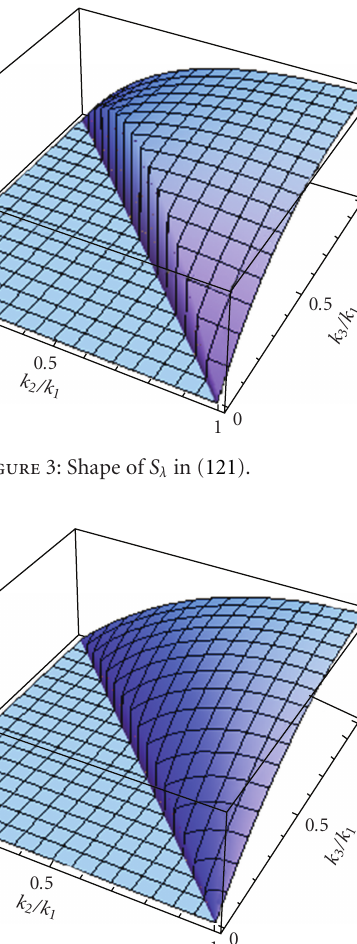
Figure 4: Shape of S c in